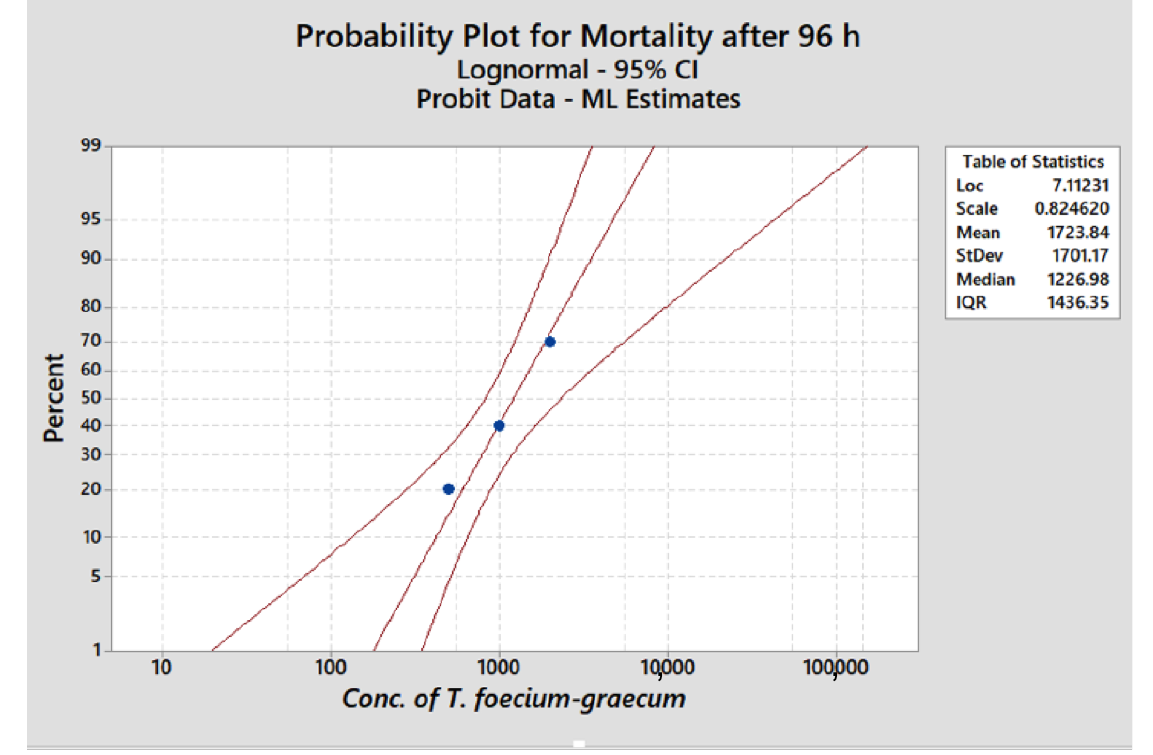
Figure 1. The mortality of C. carpio expressed as percent at different concentrations of T. foenum- graecum during the 96 h acute toxicity test.